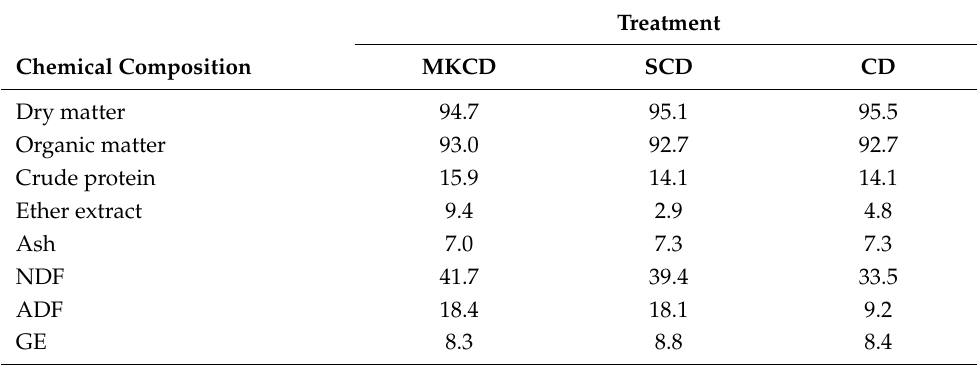
Table 2. Chemical composition (% on DM) and gross energy (MJ/kg) content of treatment